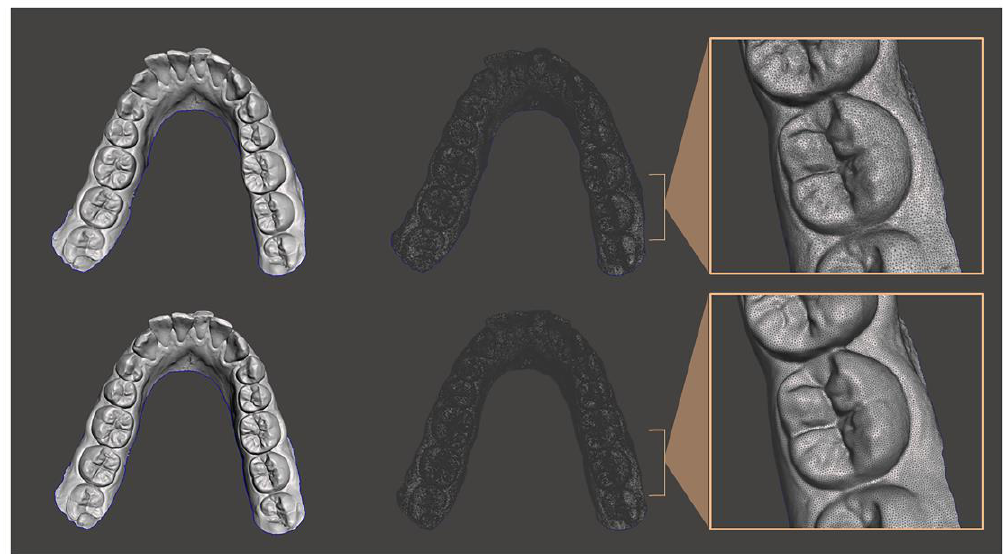
Figure 3. The quality of the model’s mesh is optimized to increase the accuracy in case of 3D printing, using Mesh-Mixer software (Autodesk, San Rafael, CA, USA).